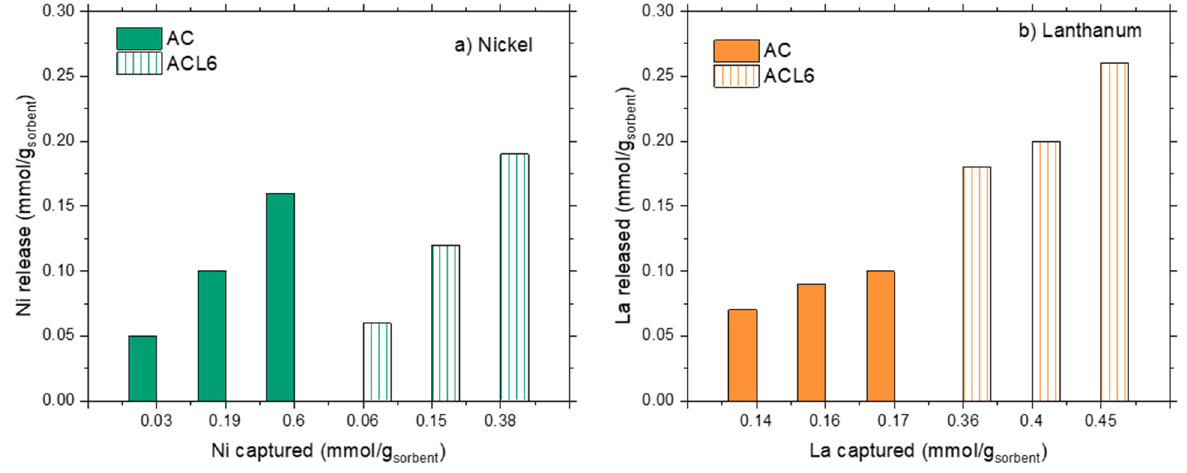
Figure 8. Metal release as a function of the metal capture for AC and ACL6.